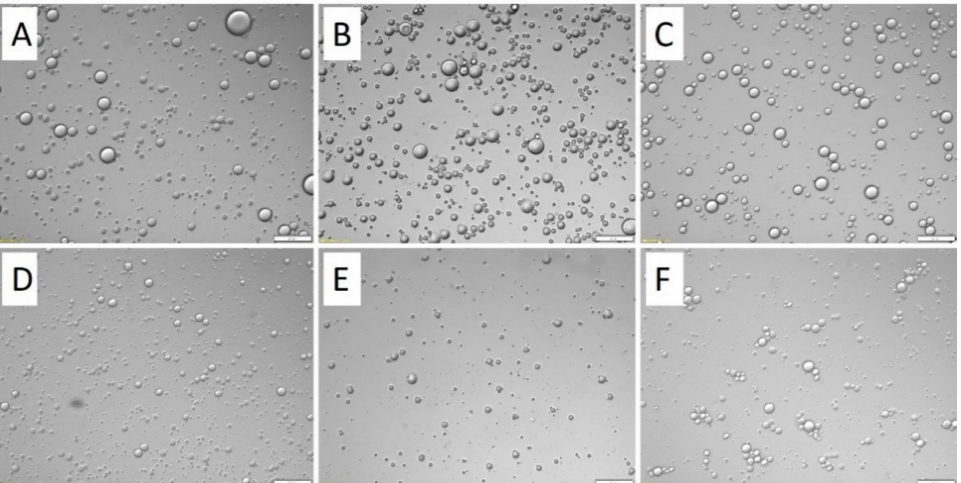
Figure 3. Optical microscopy images of peppermint oil complex coacervate microcapsules with different Polymer:Oil ratios before (upper row) and after (bottom row) spray drying. Polymer:Oil = 1:2 ( A , D ), Polymer:Oil = 1.1 ( B , E ), Polymer:Oil = 2:1 ( C , F ). Crosslinker concentration = 5% ( w : w ) with respect to BSA for all capsules. The scale bar corresponds to 50 µ